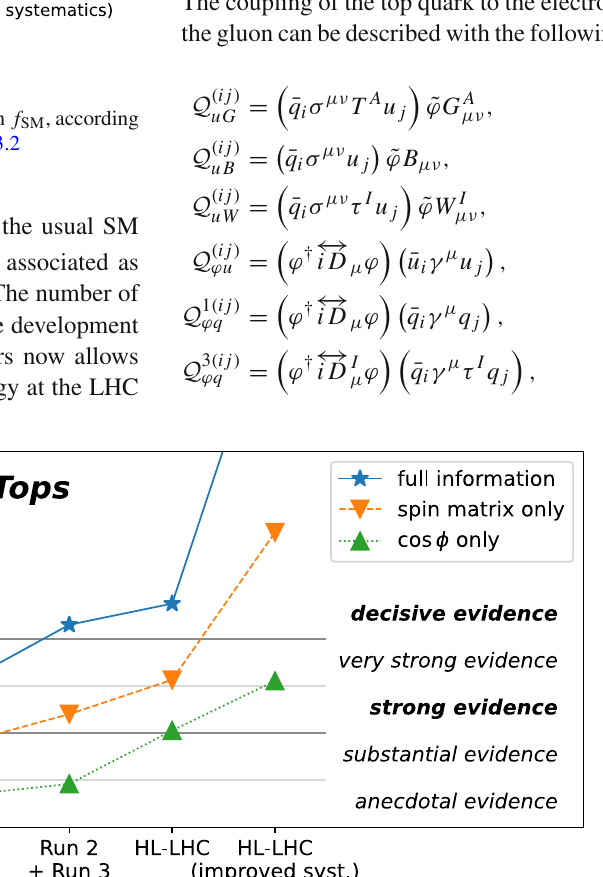
Fig. 4 Evolution of the Bayes factor K characterising the rejection of the no-spin hypothesis for the various scenarios described in the text of Sect. 3.2. The qualitative description for various ranges of K is taken from Ref. [30]; the ones in bold correspond to the 3 σ and 5 σ frequentist